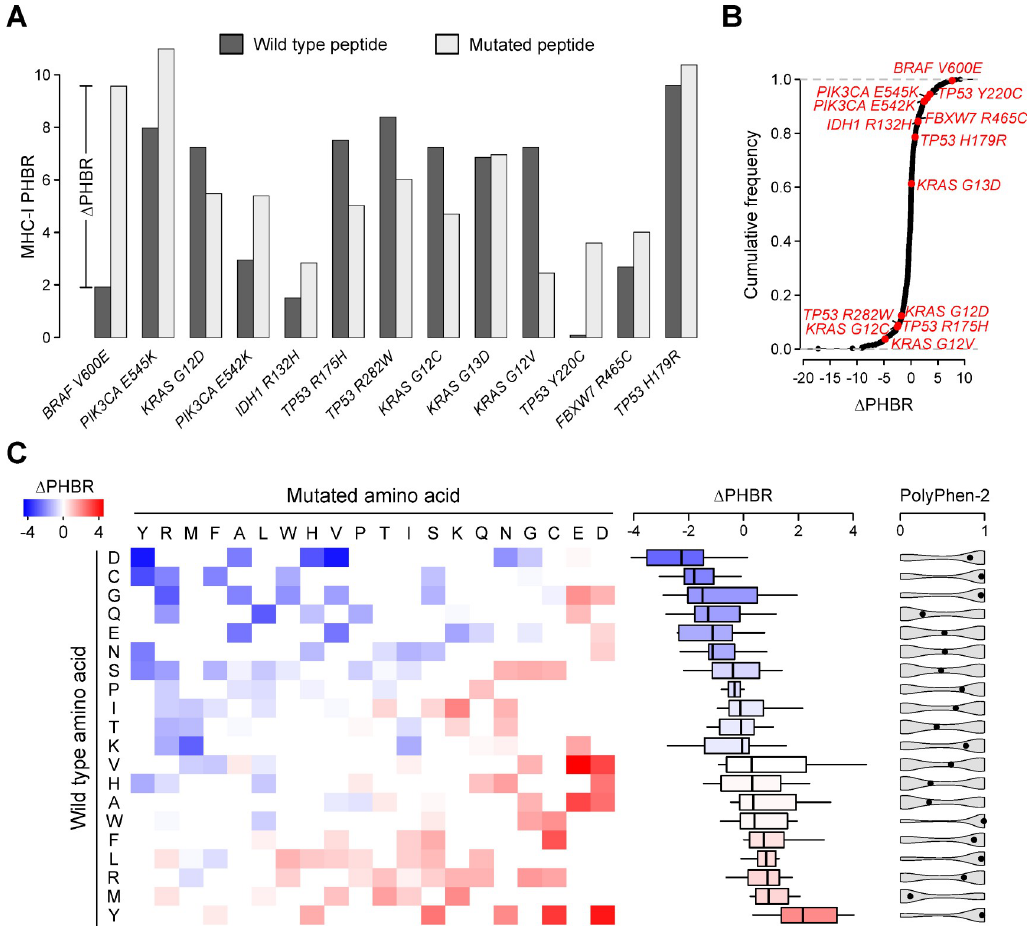
Fig 4. Differential PHBR analysis. (A) Bar plots comparing MHC-I PHBR values between wild type (PHBR wt ) and mutated peptides (PHBR), translated from the 13 identified weak HLA affinity driver mutations. Δ PHBR is defined as the difference between PHBR and PHBR wt as illustrated for BRAF V600E . (B) ECDF plot for all driver mutations in the dataset with the weak HLA affinity mutations indicated and labelled in red. (C) Heatmap showing the expected Δ PHBR for each potential substitution in the human genome, based on 15,000 random simulations. Color key shown on top left. Rows and columns are ranked on median PHBR values as indicated by the box plots on the right of the heatmap. Violin plots show PolyPhen-2 functional impact scores for the corresponding substitutions. Box plots indicate median values and lower/upper quartiles with whiskers extending to 1.5 times the interquartile